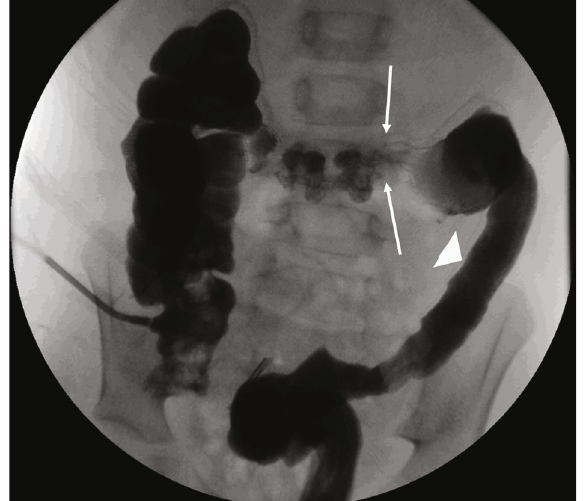
Figure 3: Frontal image from antegrade water-soluble contrast study through the cecostomy demonstrates narrowing of the left colon, with loss of the haustral markings (small arrow). A transition point is identi fi ed in the distal transverse colon (arrows). A more proximal transverse colon has normal haustral markings but is incompletely